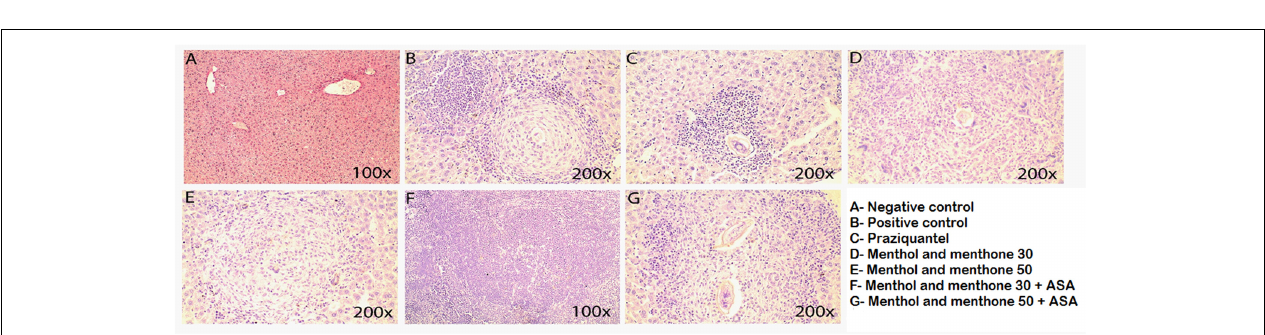
FIGURE 1 | Number of eosinophils in the blood and LPC 49 days post infection with Schistosoma mansoni . (A) Blood eosinophils (B) LPC eosinophils. ( ◦ ) There is a statistically significant difference between the results of this experimental group when compared to the control group. ( ∗ ) There is a statistically significant difference between the results of this experimental group when compared to the infected untreated group. Data is presented as mean ± SEM. The difference was considered significant when p < 0.05.